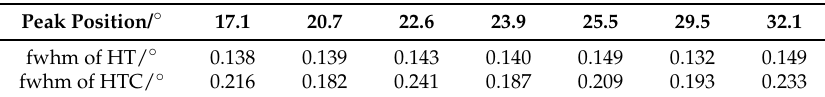
Figure 5. ( a ) XRD Comparison of sample BHT, HT and HTC; ( b ) SEM images of sample HT and HTC. Obvious particle growth and agglomeration can be seen in sample HT.